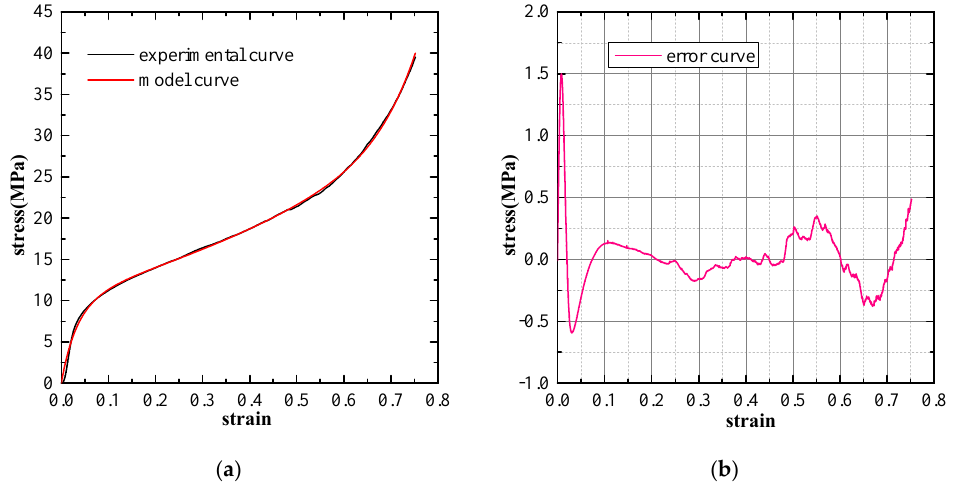
Figure 10. ( a ) Comparison between the curve predicted by the Avalle model and the experimental curve ( ρ ∗ / ρ s = 0.326); and ( b ) model prediction error.